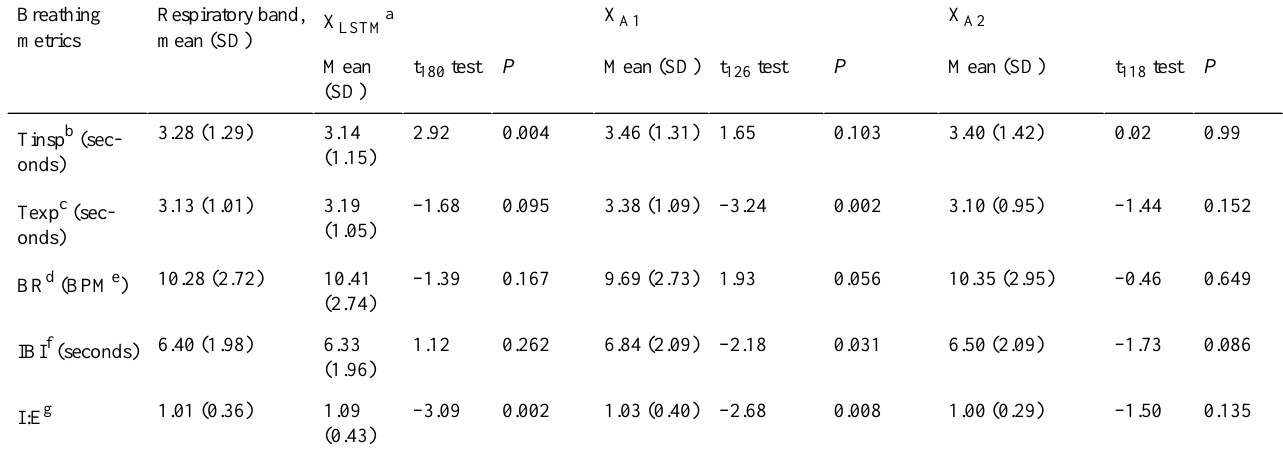
Table 3. Breathing metrics for the reference respiratory band, X LSTM, X A1 , and X A2 methods, with their associated paired t test